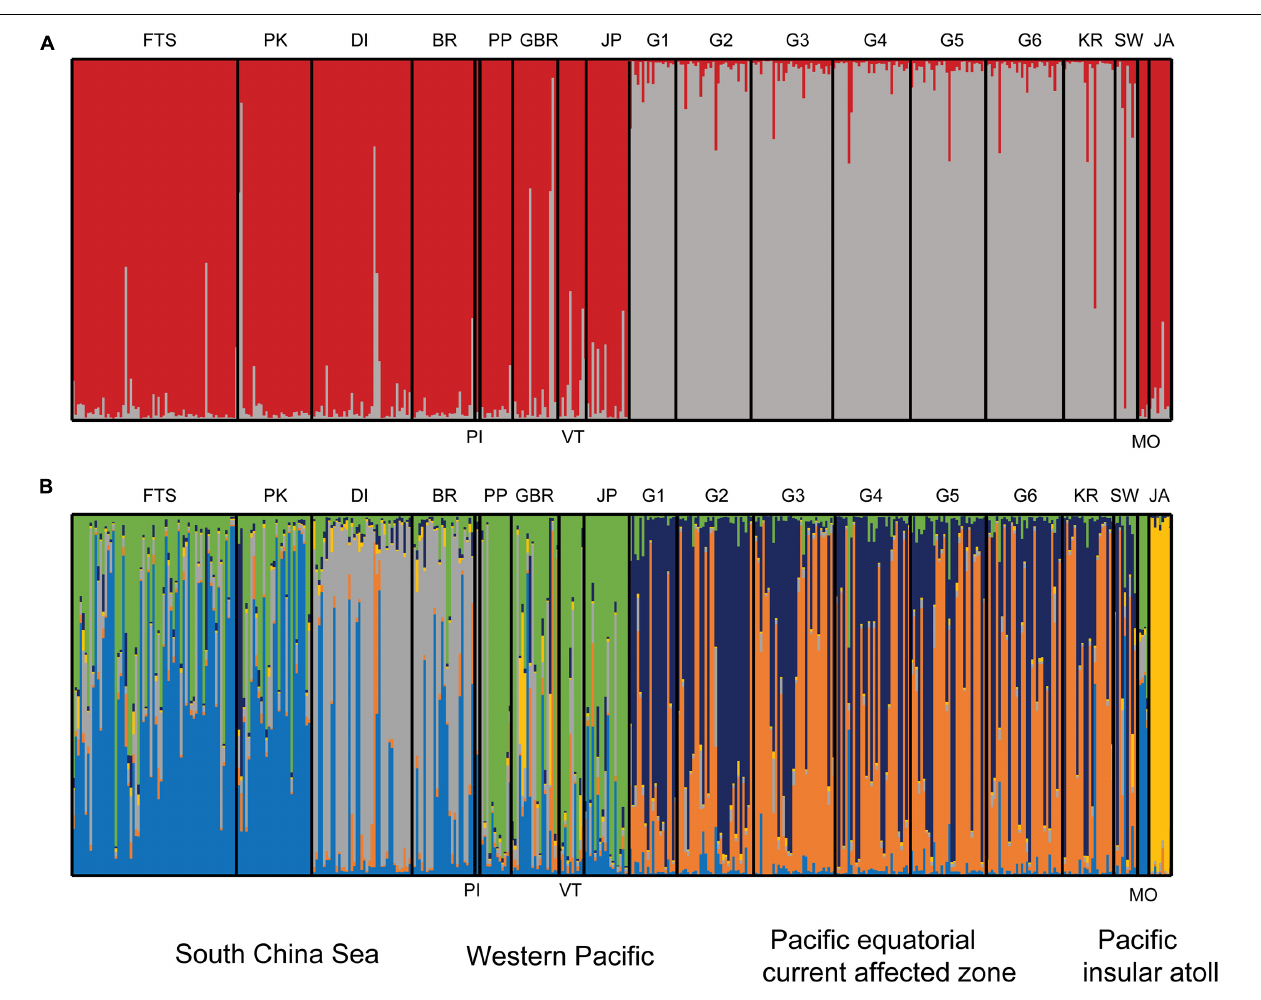
FIGURE 4 | Genetic structure of crown-of-thorns starfish (COTS) in the Pacific Ocean. (A) At the optimal K = 2, COTs sample were assigned to two genetic groups, sampling sites in Pacific equatorial currents affected zone (PECAZ) were significantly distinct from all other locations. (B) A second optimal K = 6, six genotypes were identified in COTS populations. The South China Sea (SCS) mainly has blue genetic cluster in First Thomas Shoal-Passu Keah (FTS and PK) and gray genetic cluster in Drummond Island (DI), Bombay Reef (BR), and Pattle Island (PI); The Western Pacific (WP) mainly has a green genetic cluster, which includes Japan (JP), the Philippines (PP), Great Barrier Reef (GBR), and Vanuatu (VT); the Pacific equatorial currents affected zone (PECAZ) has mixed genotypes (orange and dark blue; G1, Guam-Tipalao; G2, Guam-Uruno; G3, Guam-Taguan; G4, Guam-Notth Haputo; G5, Guam-Tanguisson; G6, Guam-Tagachan; KR, Kingman Reef; SW, Swains), and the Pacific insular atoll (PIA; JA, Johnston Atoll; MO, Moorea) has yellow genetic cluster.